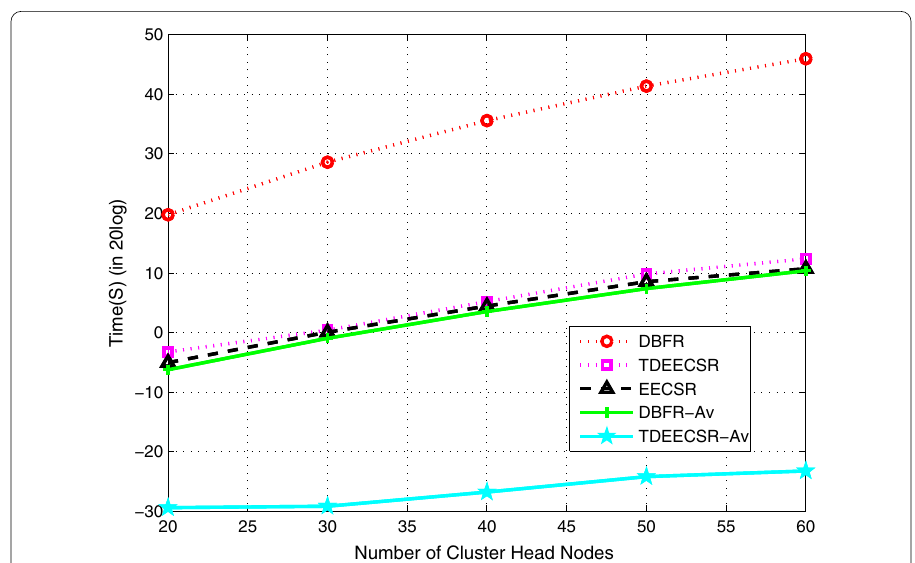
Fig. 11 Time delay of route discovery (in logarithmic scale) versus CH